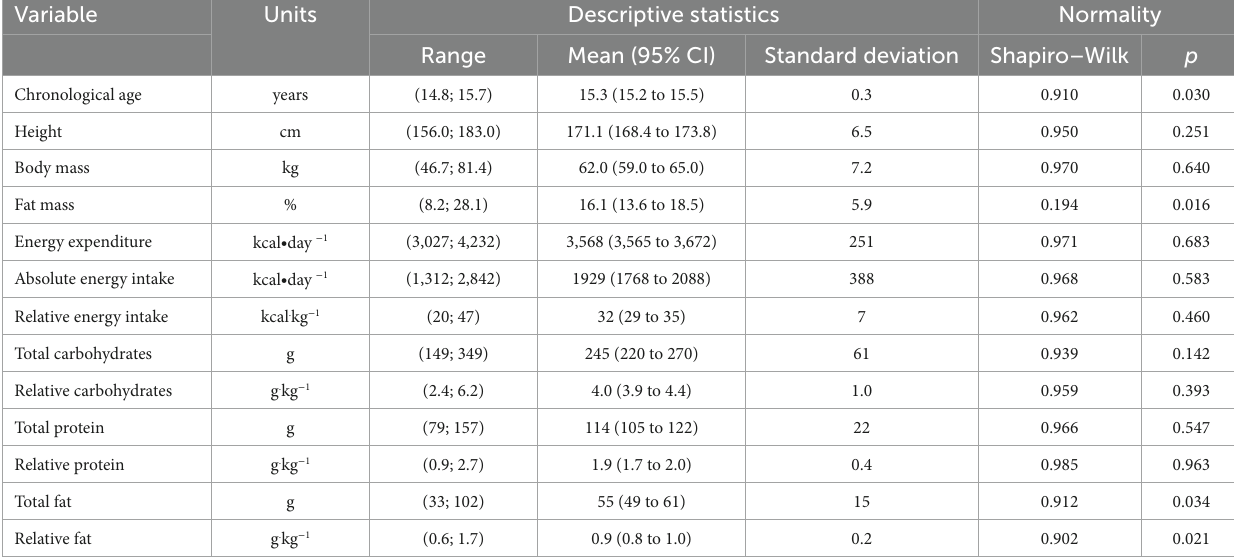
TABLE 1 Characteristics, dietary intake and energy expenditure for the sample of male soccer players.